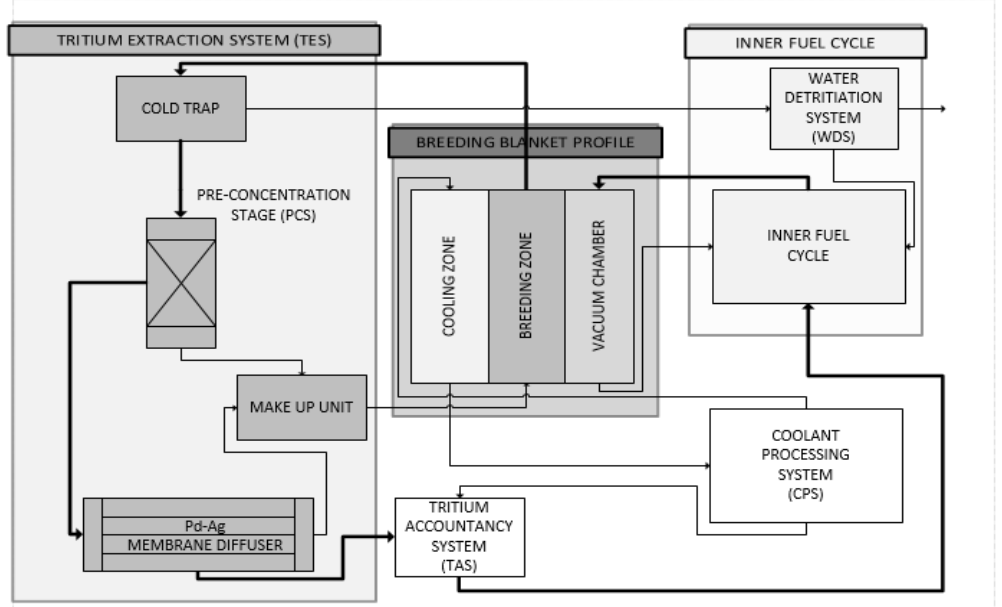
Figure 1. Block diagram of the fuel cycle in DEMO for a helium cooled pebble bed (HCPB) blanket. Two streams leave the extraction system: (i) hydrogen isotopes coming from the permeate side of the Pd-Ag separator which are sent to the inner fuel cycle before being reinjected inside the